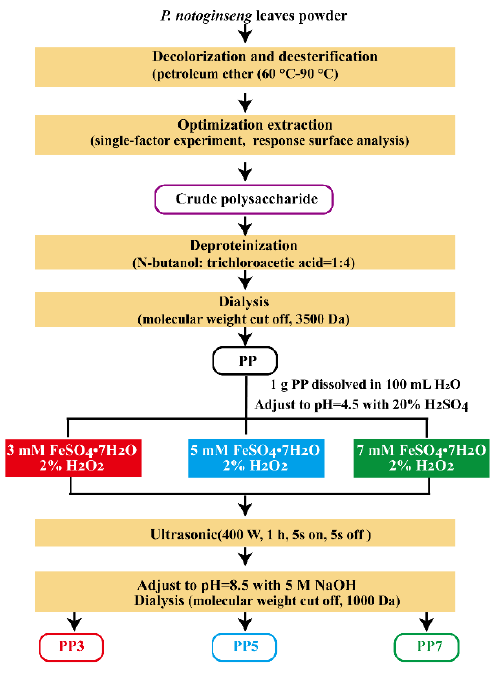
Figure 10. The extraction process and Fenton degradation reaction of polysaccharides from P. noto- ginseng leaves. P. notoginseng